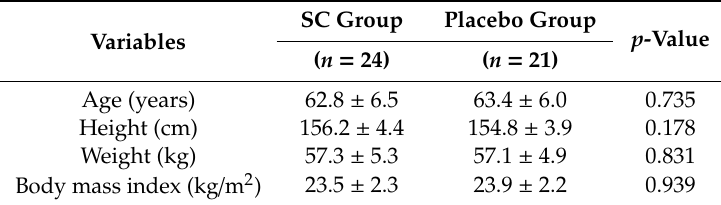
Table 1. The characteristics of the subjects.